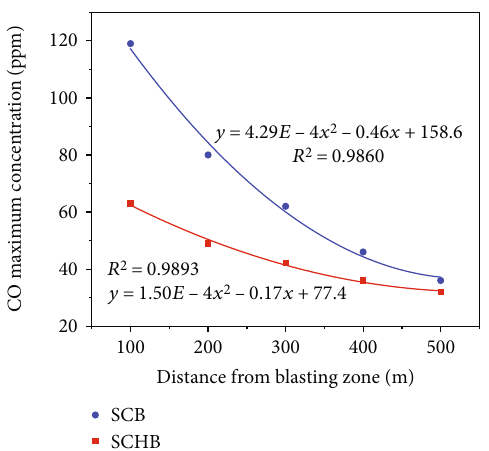
Figure 13: Changes in maximum CO concentration with monitoring distance in single-hole SCB and SCHB.